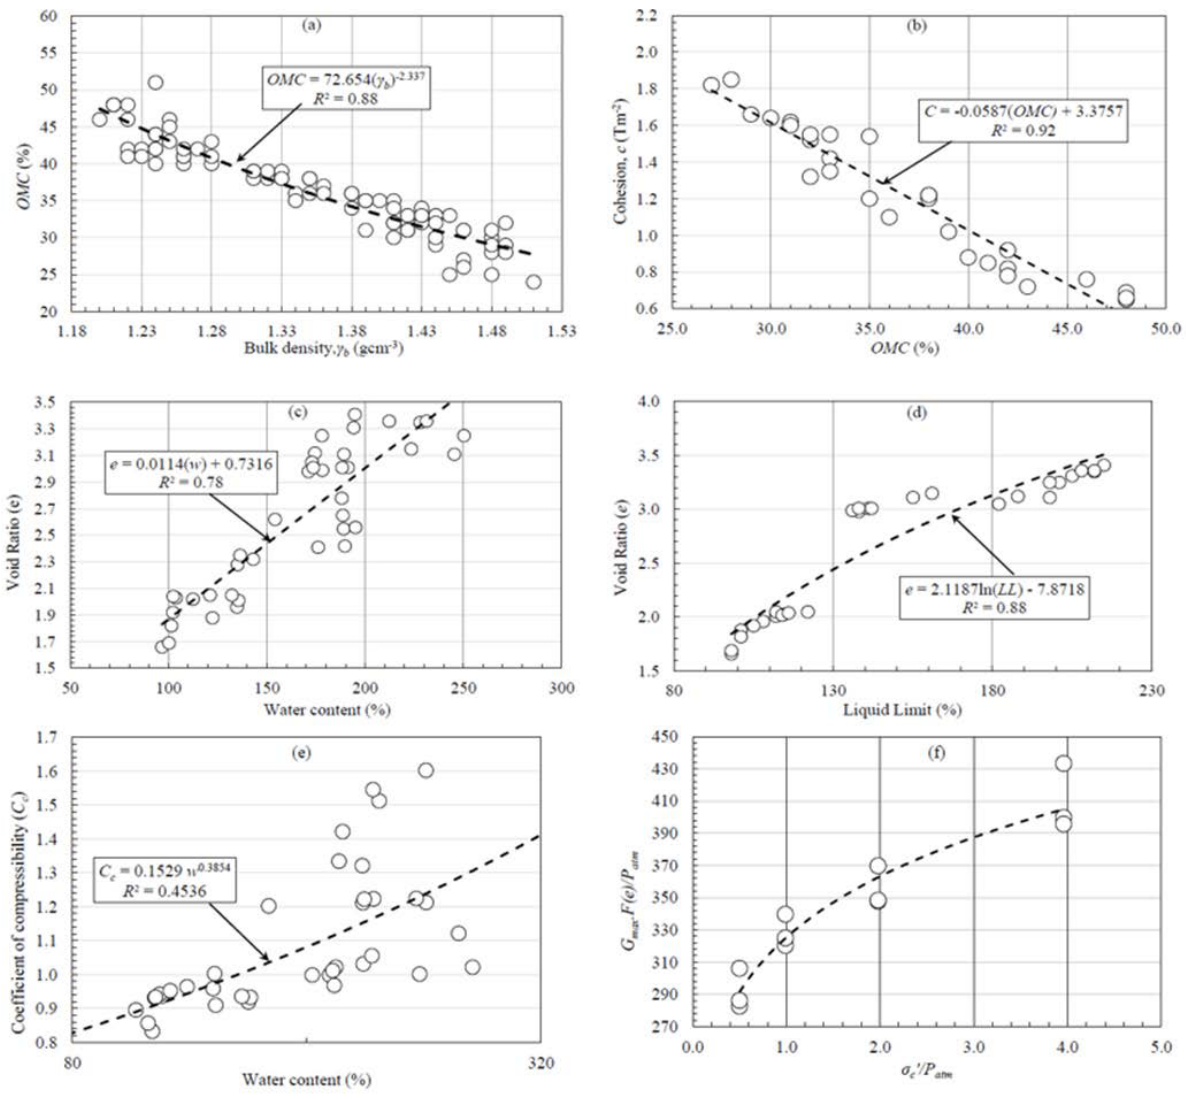
Figure A6. Proposed empirical equations of physicochemical parameters for Agartala peat: (a) bulk density with organic matter content (OMC), (b) cohesion with OMC, (c) void ratio with OMC, (d) void ratio with liquid limit, (e) coefficient of compressibility with water content, (f) proposed best-fit G max relationship equation for Agartala